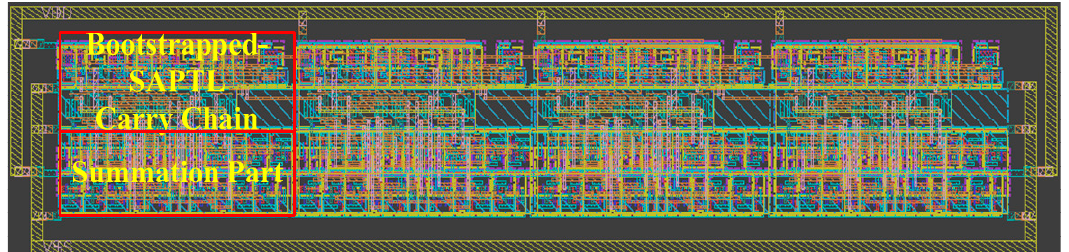
Figure 14. The layout of the proposed 16 bit adder.